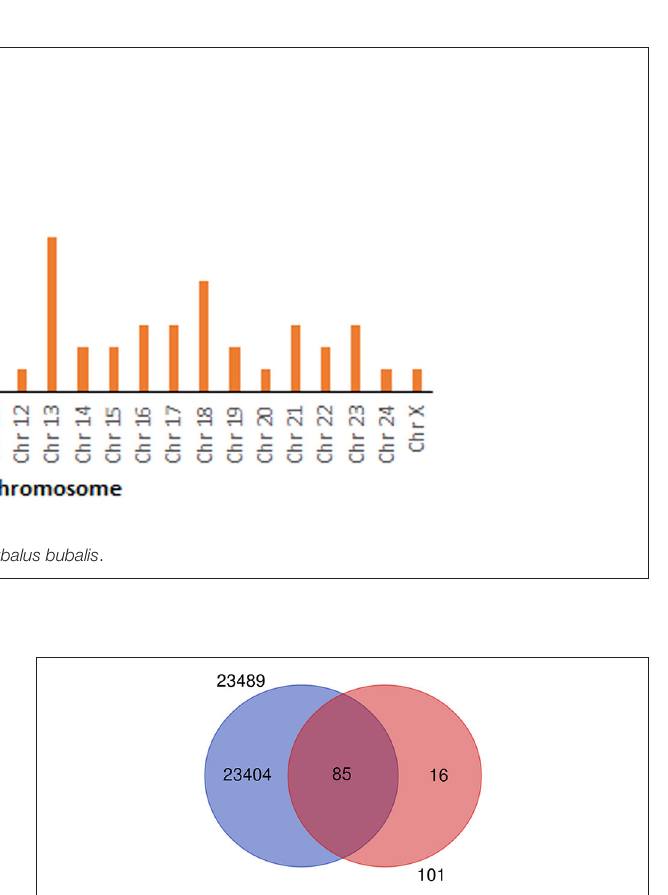
FIGURE 3 | Venn diagram showing the common and unique genes when compared to gene expression atlas of water buffalo and genes from milk